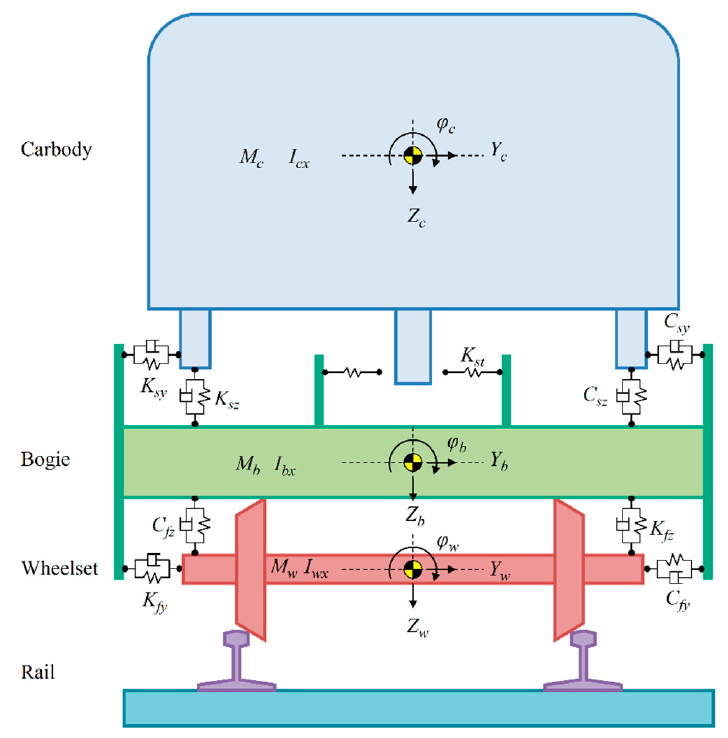
Figure 4. Vehicle system dynamics model based on multi – rigid body theory.